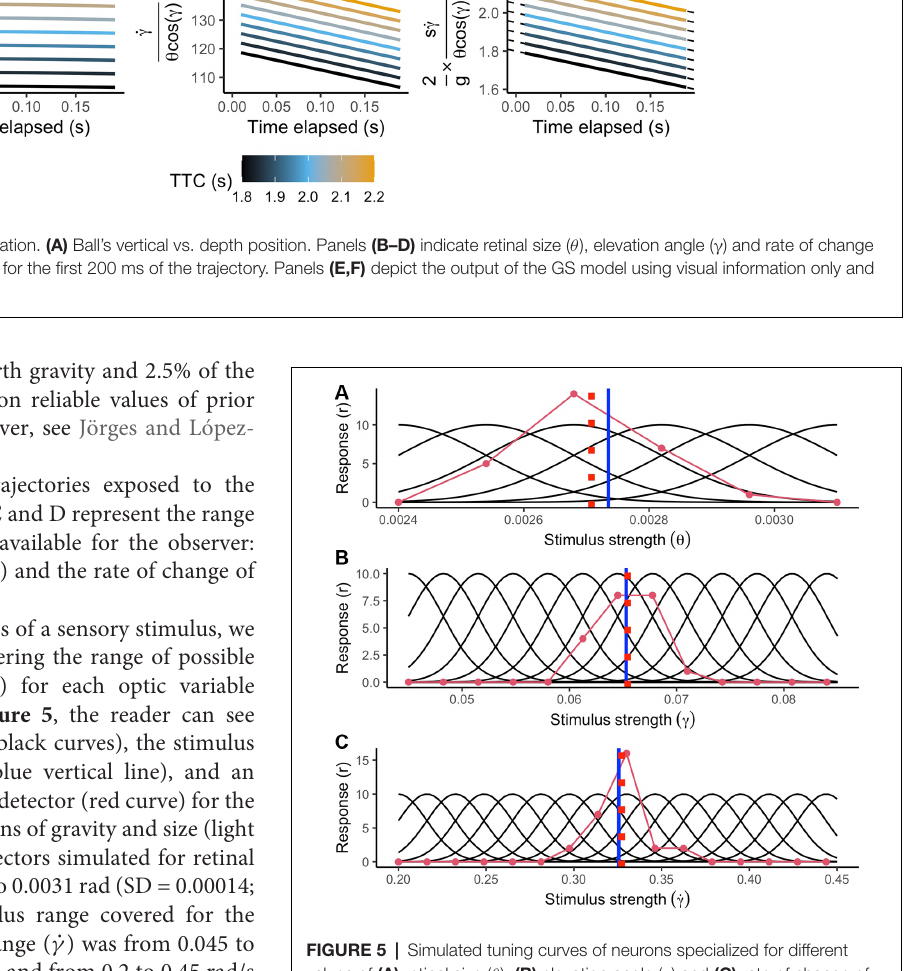
FIGURE 5 | Simulated tuning curves of neurons specialized for different values of (A) retinal size ( θ ), (B) elevation angle ( γ ) and (C) rate of change of the elevation angle ( ˙ γ ). The blue vertical line indicates the true stimulus strength exposed to the system. The stimulus strength was selected from the standard condition 200 ms after motion onset (see main text). The red curve indicates the average activation per neuron in a single trial (Poisson noise added). The red dashed lines indicate the stimulus strength inferred by the encoding